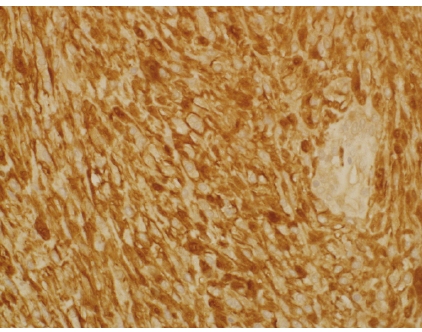
Figure 3: Immunohistochemical examination of the pancreatic tail tumor showed diffuse and strong positivity to S100 protein (magnification power: